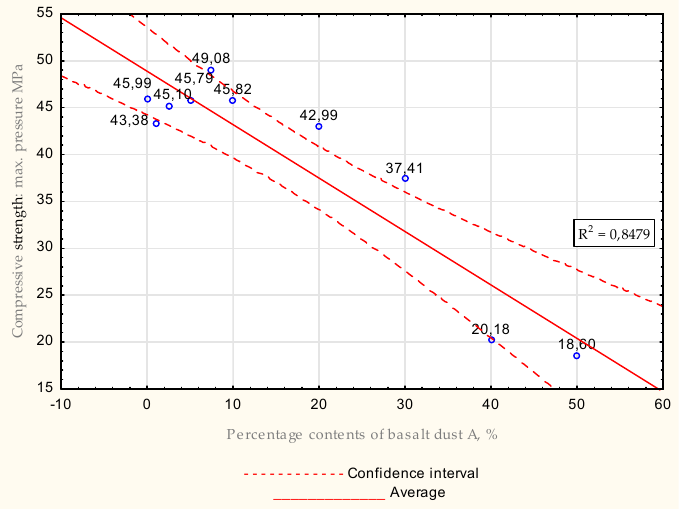
Figure 18. Average values received during compressive strength tests for water − mix ratio = 0.5, max. pressure.